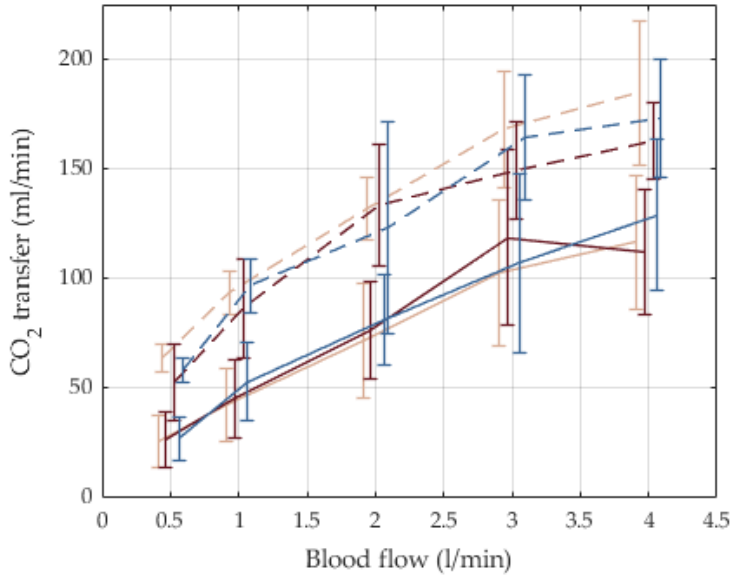
Figure 10. Carbon dioxide transfer rates for different feed gas blends and gas/blood-flow ratios, n = 5, mean and SD. Beige: feed gas with pure ambient air, F i O 2 = 21%; red: feed gas blend with F i O 2 = 50%; blue: feed gas with medical oxygen, F i O 2 = 100%. Solid line: 1:1 flow ratio gas/blood; dashed line: 4:1 flow ratio gas/blood.